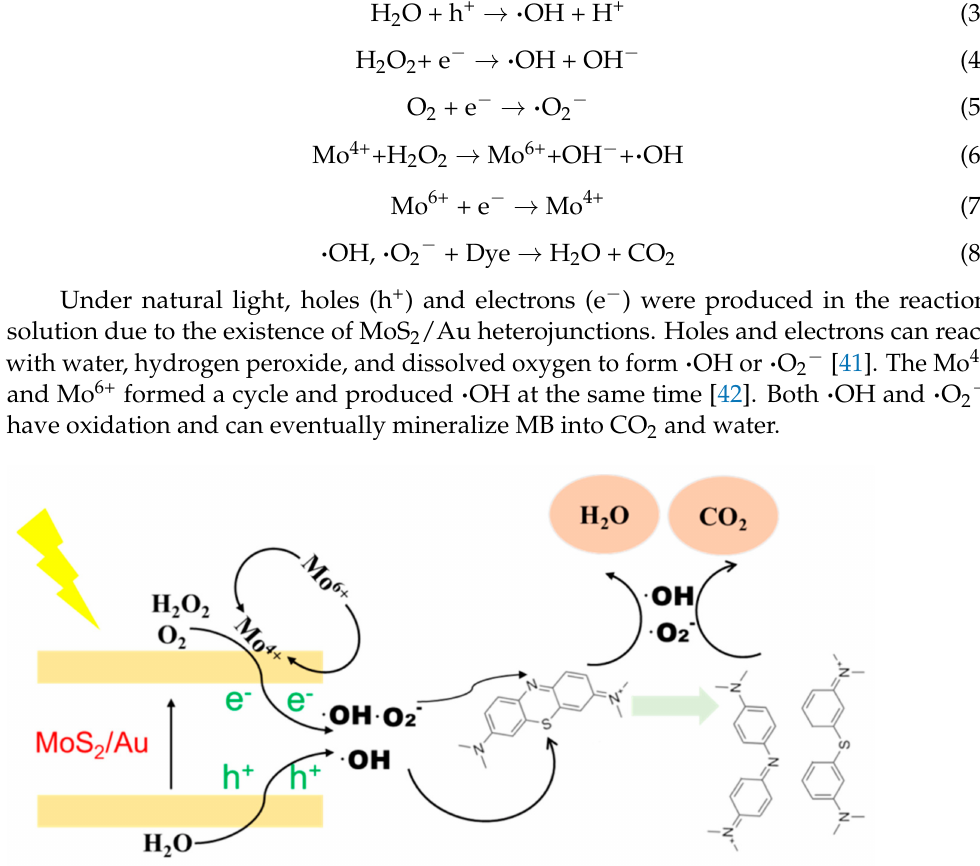
Figure 4. Schematic diagram of the possible Fenton-like catalytic mechanism of MoS 2